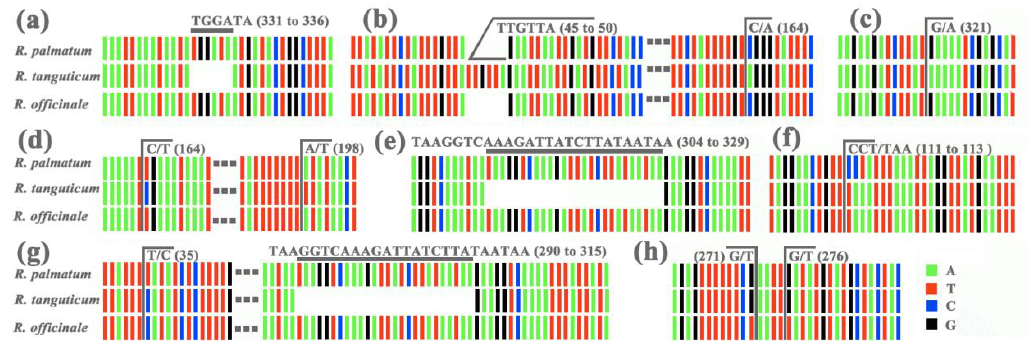
Figure 5. Base information of the identification sites of sequences obtained by chosen primer pairs for the three study species. ( a ) Primer pair 1; ( b ) Primer pair 7; ( c ) Primer pair 9; ( d ) Primer pair 10; ( e ) Primer pair 15; ( f ) Primer pair 17; ( g ) Primer pair 21; ( h ) Primer pair 6. For more detailed information on primer pairs see Table S3.